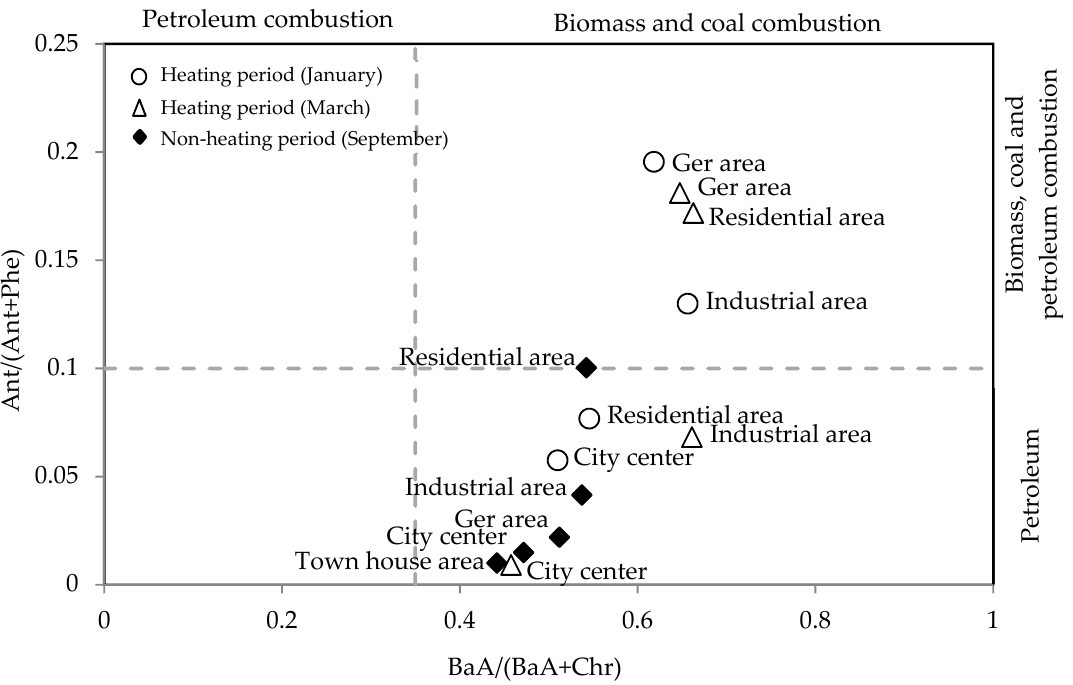
Figure 5. Cross plot of the diagnostic ratios for the sources of PAHs in winter and late summer.